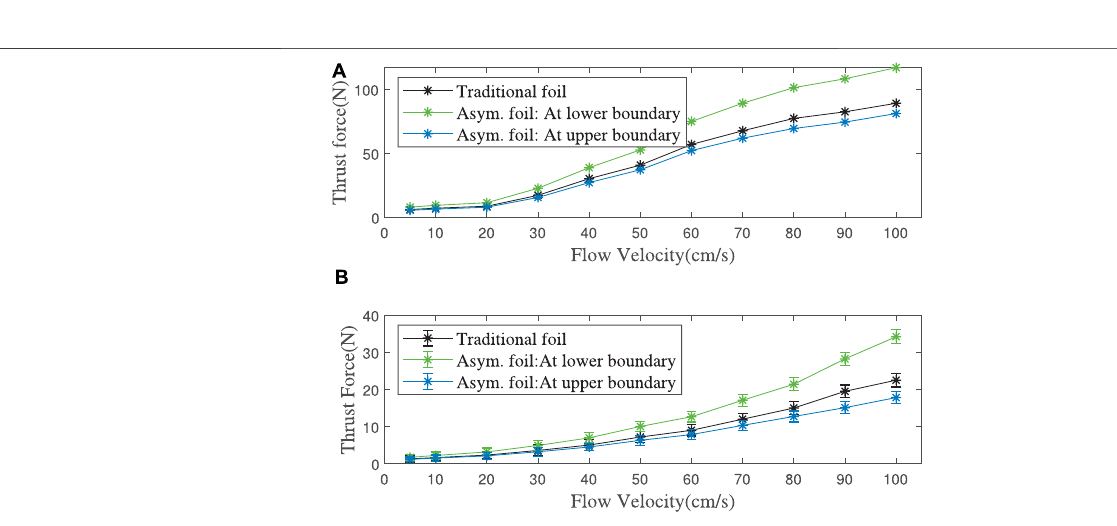
FIGURE 8 | (A) Simulation: Foils ’ thrust force in different fl ow velocities. (B) Experiment: Foils ’ thrust force with different fl ow velocities at upper (pitching up)/lower (pitching down) limit angles, mean value of 10 experiments ’ data.